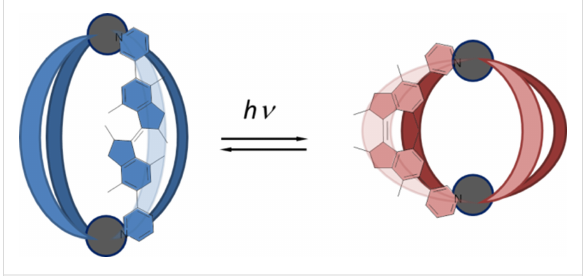
Figure 1: Schematic representation of a photoresponsive cage with ligands based on overcrowded